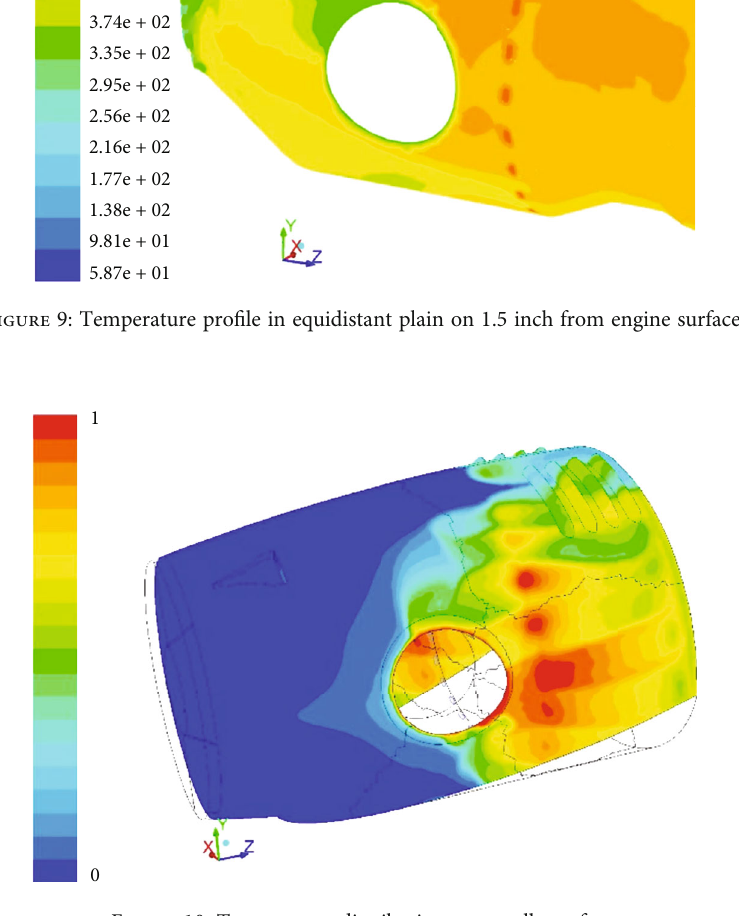
Figure 10: Temperature distribution on nacelle